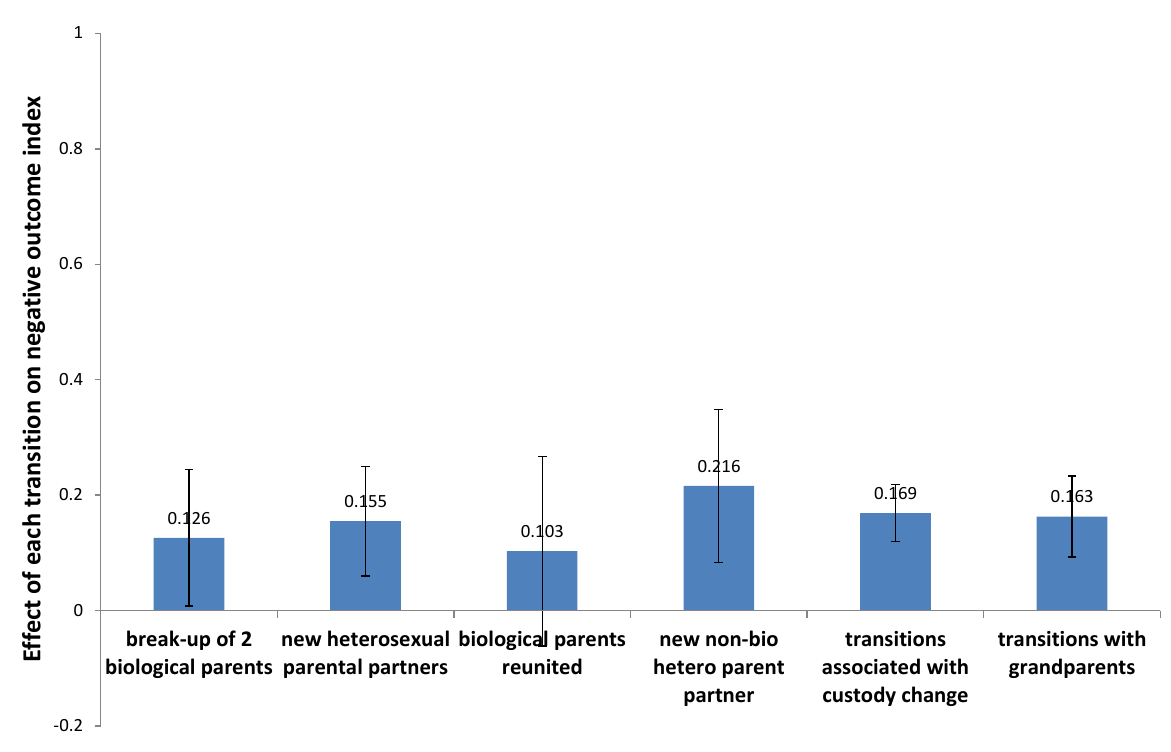
Figure 2: Different Types of Family Transitions as Predictors of the Standardized Negative Outcome Index, with 95% Confidence Intervals.